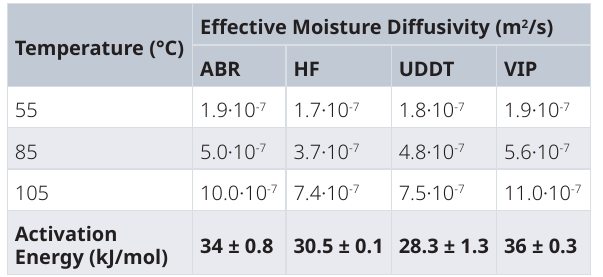
Table 7. Isothermal drying kinetic parameters of faecal